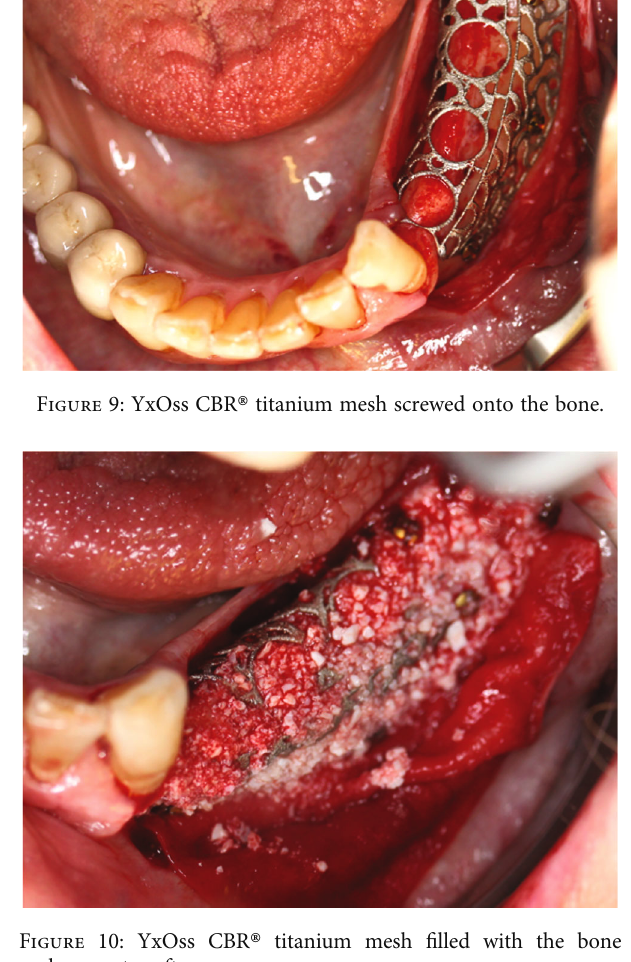
Figure 12: GORE-TEX® suture in place.